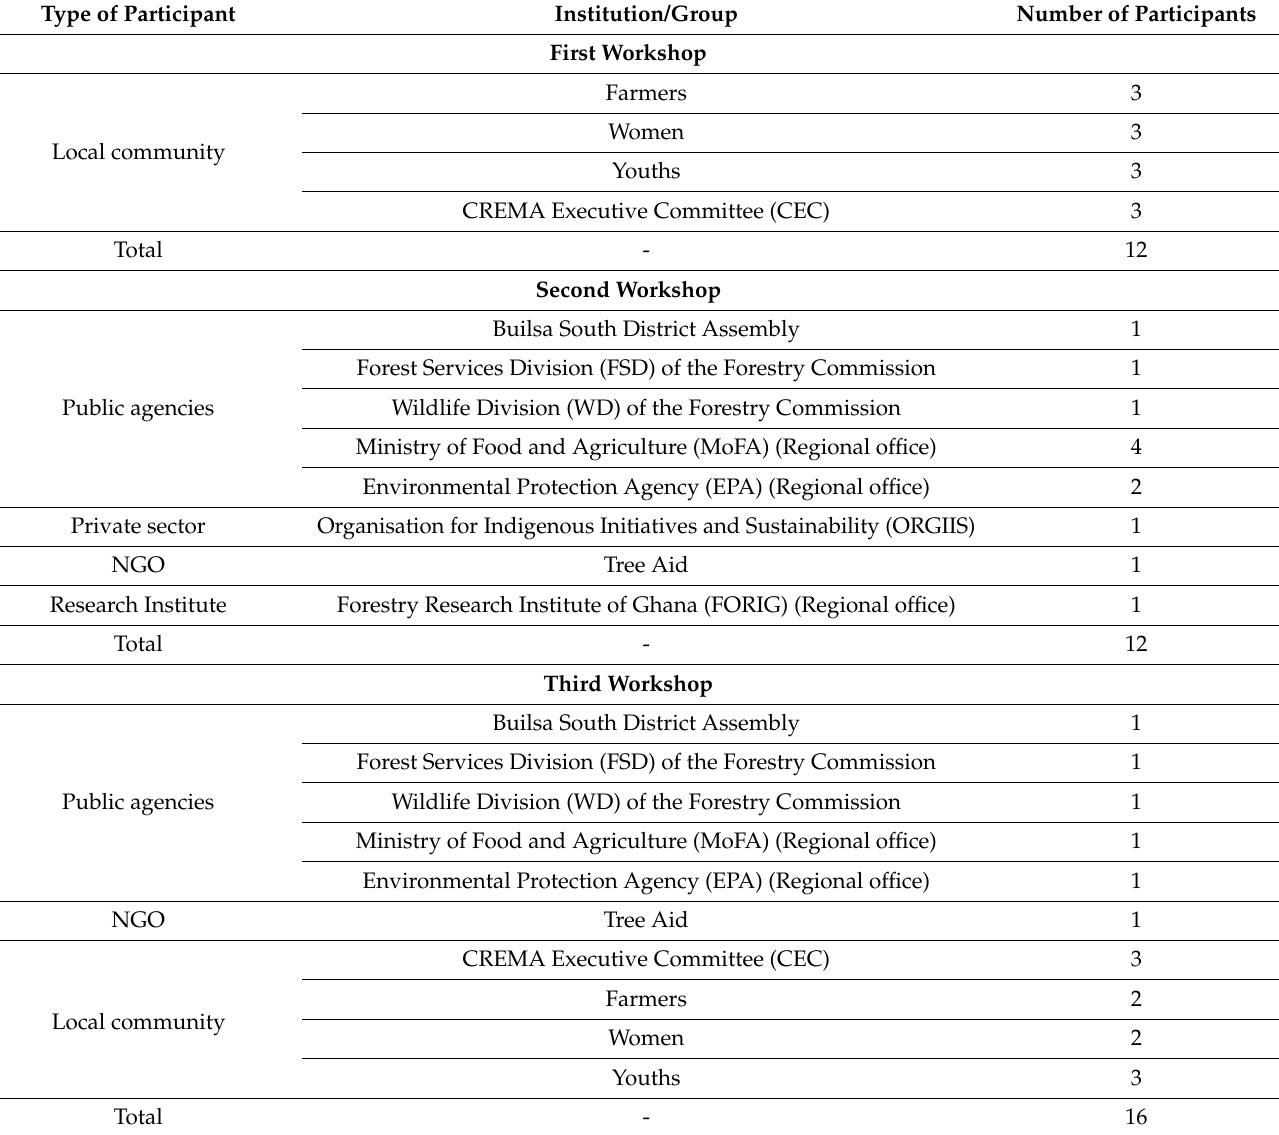
Table 1. Type of participants in the